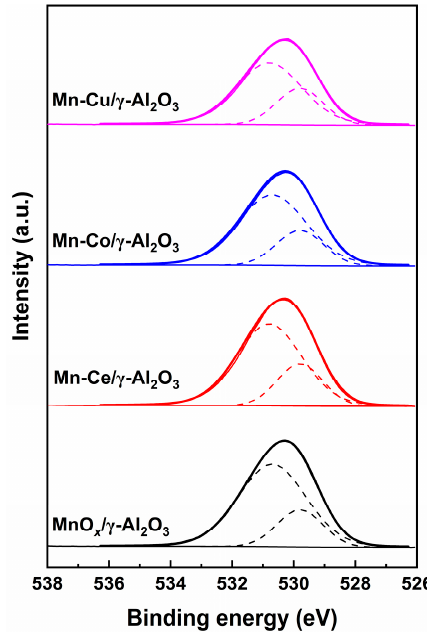
Figure 2. XPS spectra of O 1s for Mn-X/ γ -Al 2 O 3 catalysts.